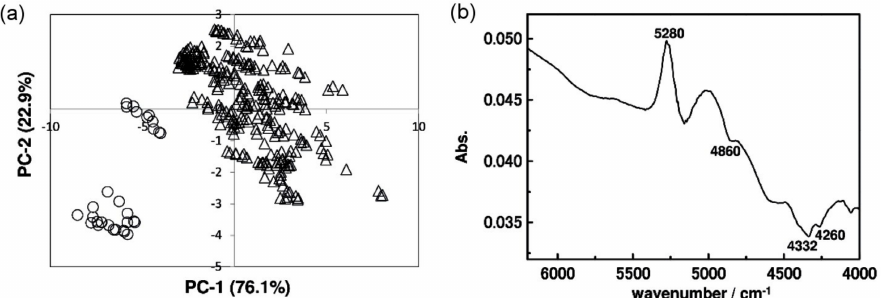
Figure 10. PCA scores plot of NIR spectra of yolk measured over the development time of Oryzias latipes embryo ( a ). ∆ indicates the data collected from the first to the tenth day and (cid:13) denotes data collected at the day before hatching. Loadings plot of PC-1 ( b ). Reproduced from Ref. [83] in agreement with CC BY 4.0